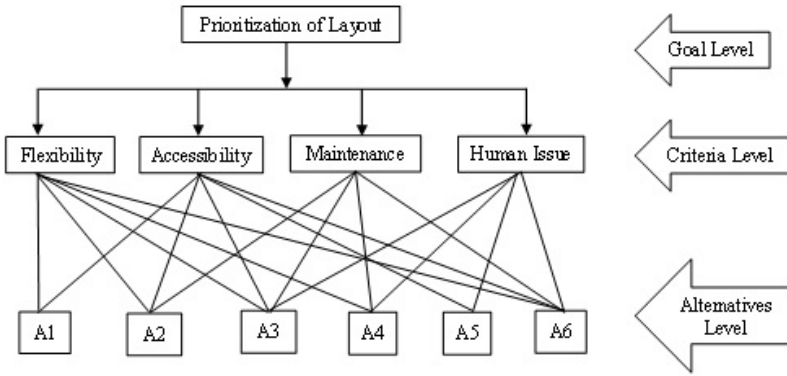
Fig. 11. Decision hierarchy for qualitative criteria in the layout selection